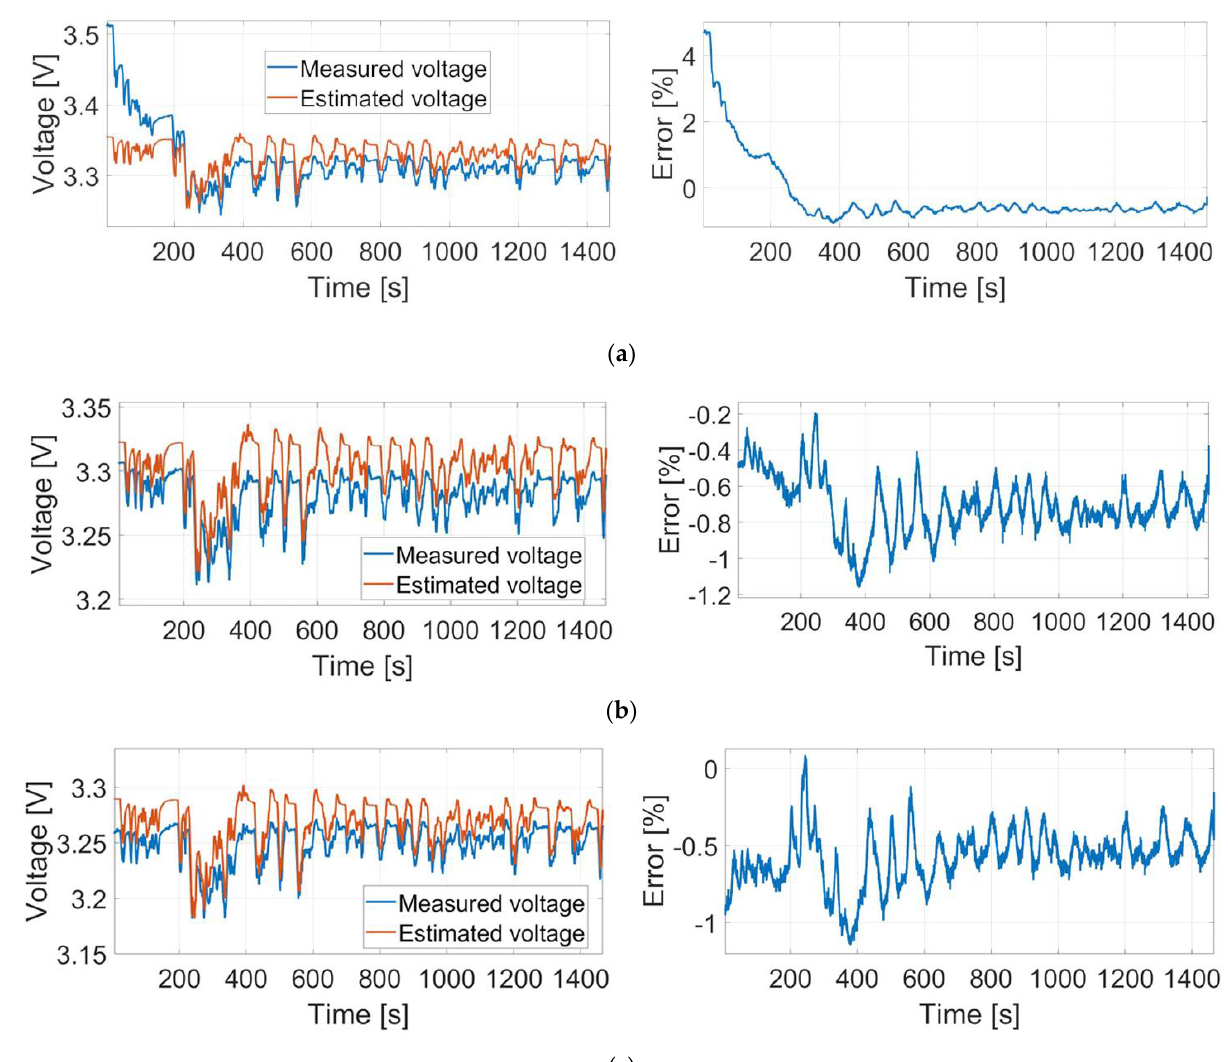
Figure 7. The real and simulated HPPC profile applied at ( a ) 100% of the SoC; ( b ) 70% of the SoC; ( c ) 30% of the SoC.